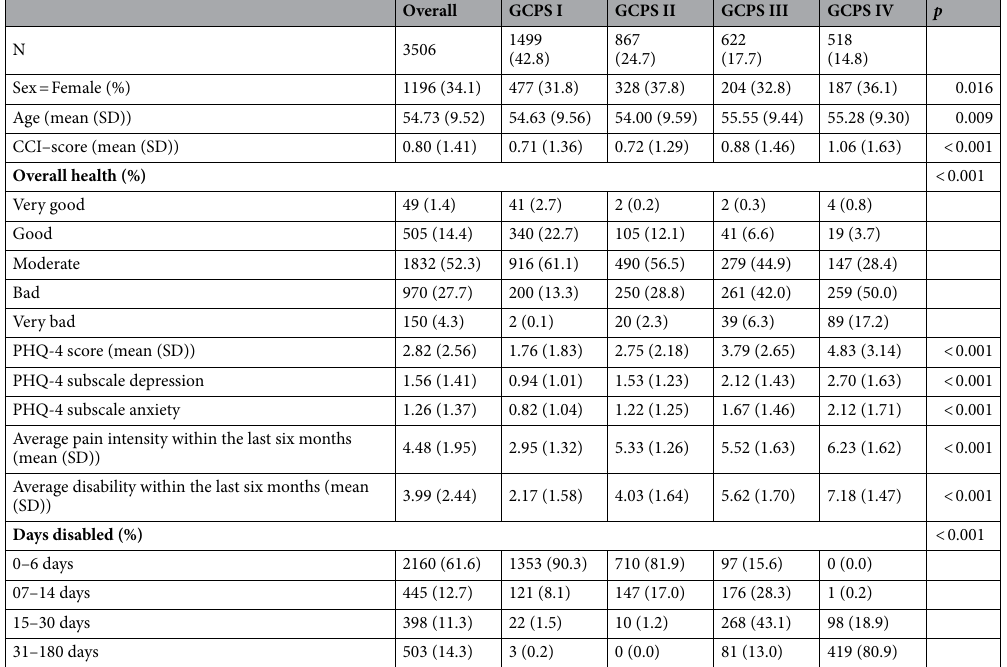
Table 2. Characteristics of study participants based on Graded Chronic Pain Grades. Definition of GCPS: Grade I Low disability-low intensity, Grade II Low disability-high intensity, Grade III High disability- moderately limiting, Grade IV High disability-severely